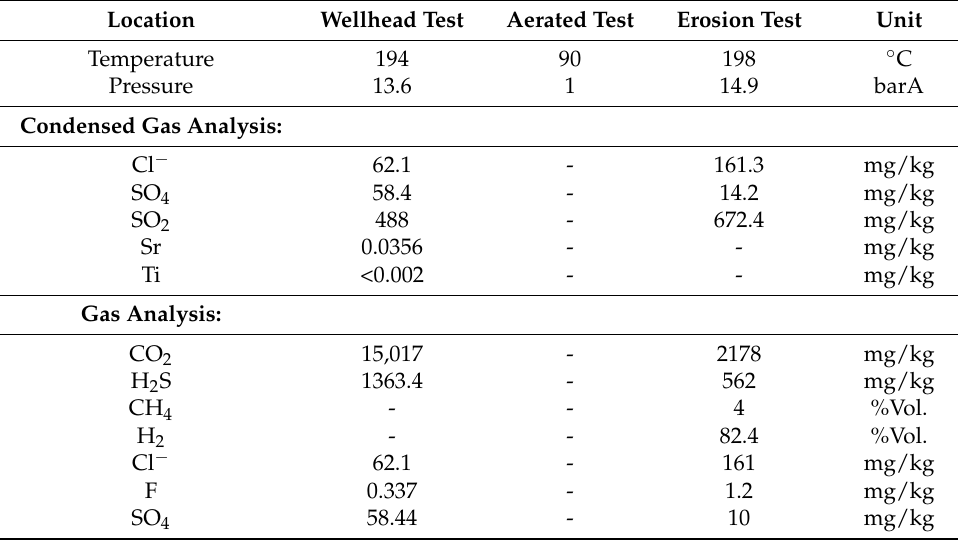
Table 2. Test conditions at the three test